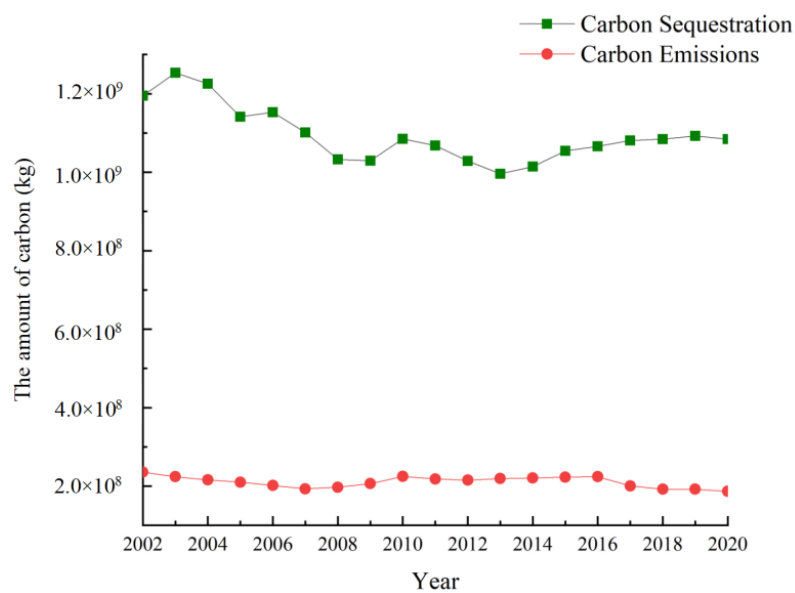
Figure 4. The carbon emissions and sequestration of urban agriculture in Guangzhou from 2002 to 2020.